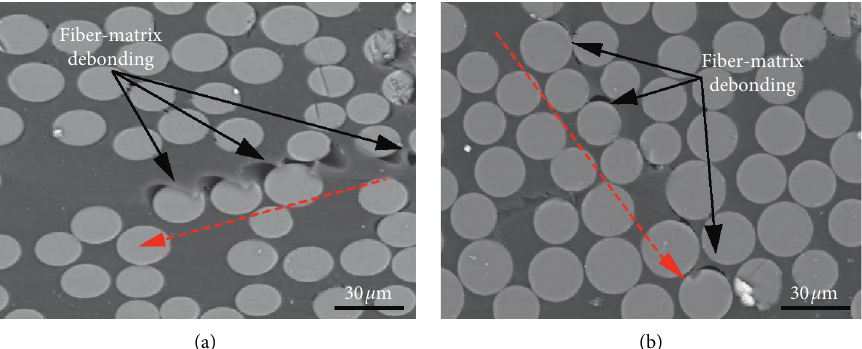
Figure 12: Debonding failure mechanism of short-beam fiber matrix, observed by SEM (FEI Quanta 200) [51]. (a) Angle-ply laminate; (b) cross-ply